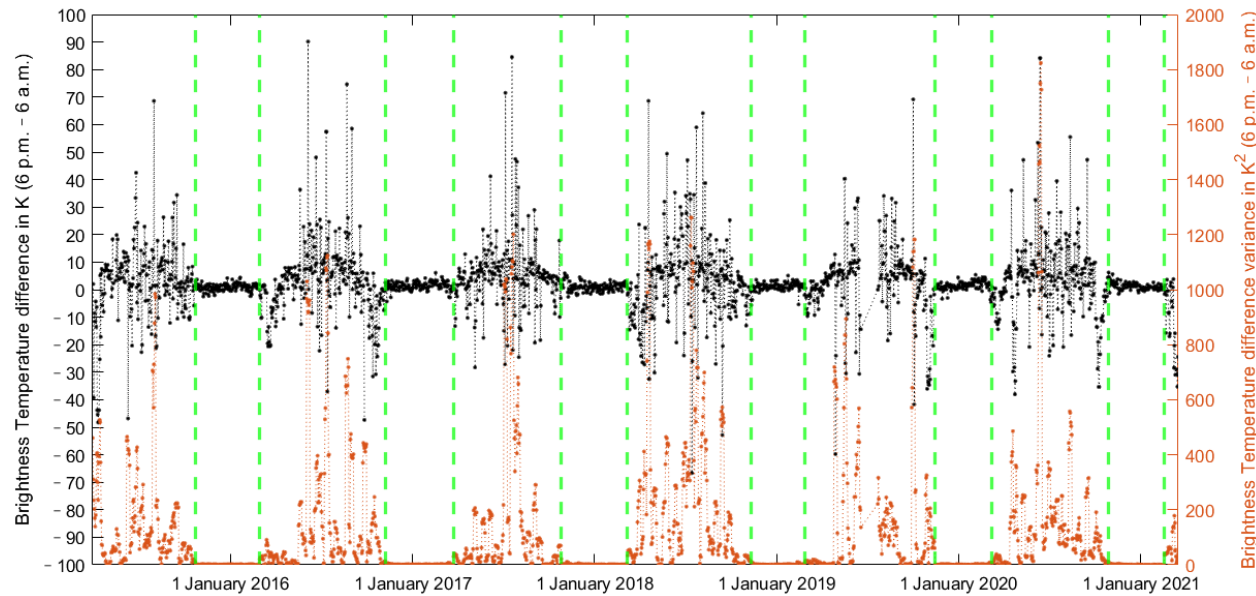
Figure 4. An illustration of diagnosis example at the Xilinhot site. The time series of Δ TB (Equation (7)) is represented by the black line from April 2015 to March 2021. The red line represents its seven-day moving variance as in Equation (9). The green dashed lines represent the beginning/ending of the soil frozen state inferred from the new FT algorithm.